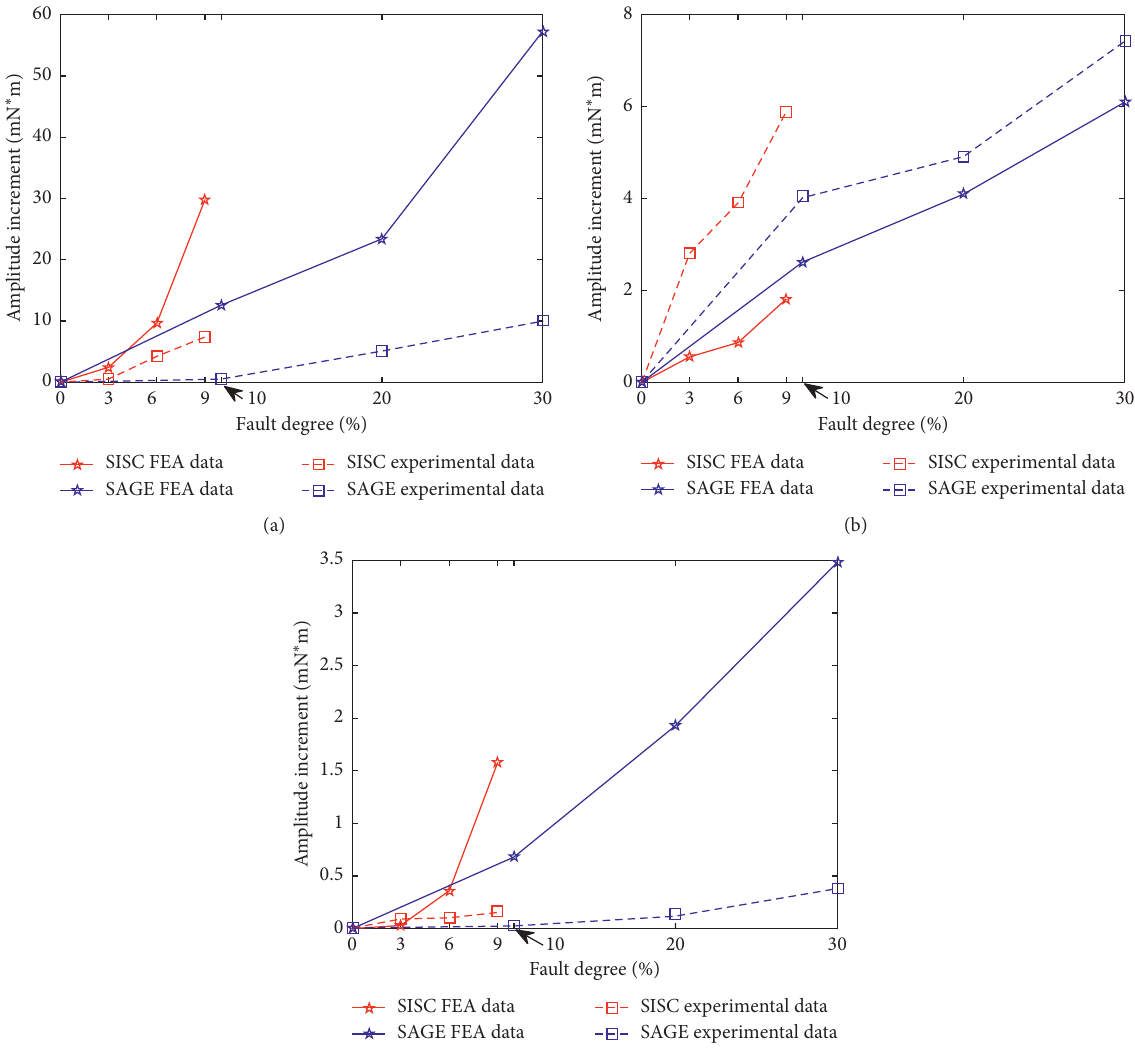
Figure 16: Impact comparison for single faults: (a) 2nd harmonic, (b) 4th harmonic, and (c) 6th